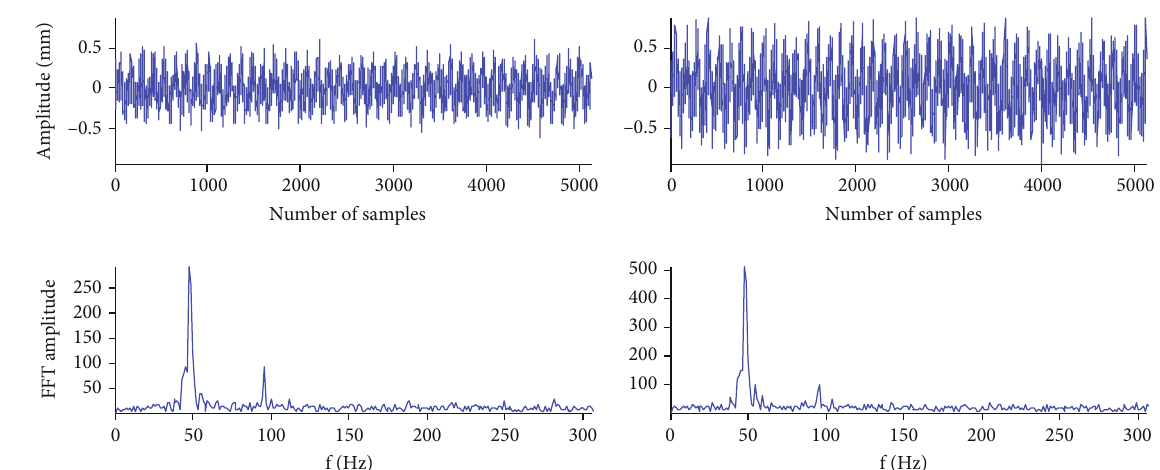
Figure 7: Multifunctional rotor test platform.